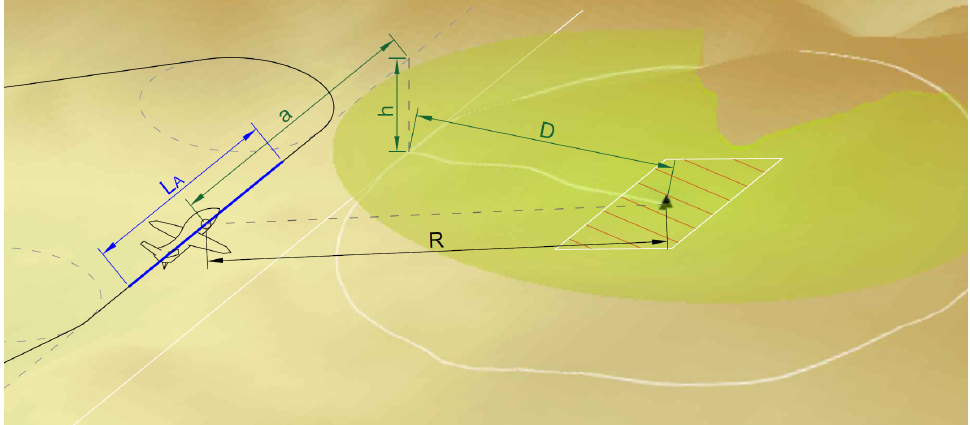
Figure 1. Graphical representation of the SAR scan’s geometrical parameters: R—slant range, D— ground distance, h—flight height (above ground level), a—offset, L A —synthetic aperture length required of flight distance. The scanned area is marked on the map with a polygon.